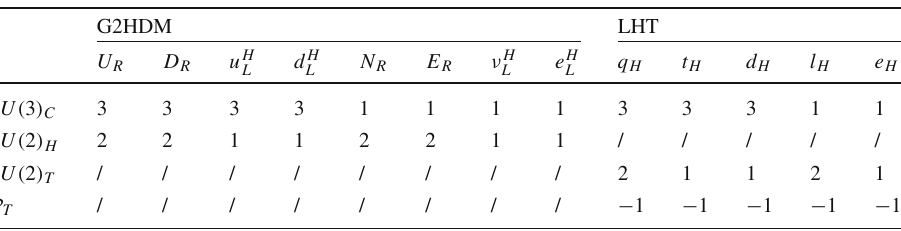
Table 4 Comparison of quantum numbers of the heavy SU ( 2 ) L singlet fermion fields in G2HDM and